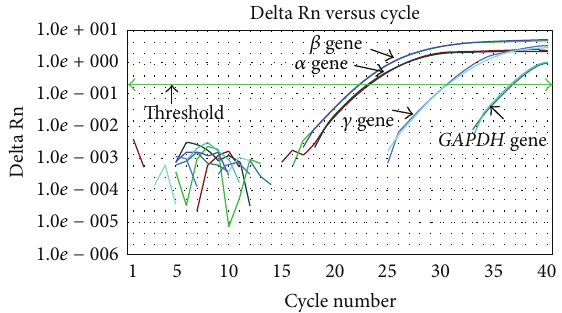
Figure 2: Delta Rn versus cycle for different genes.